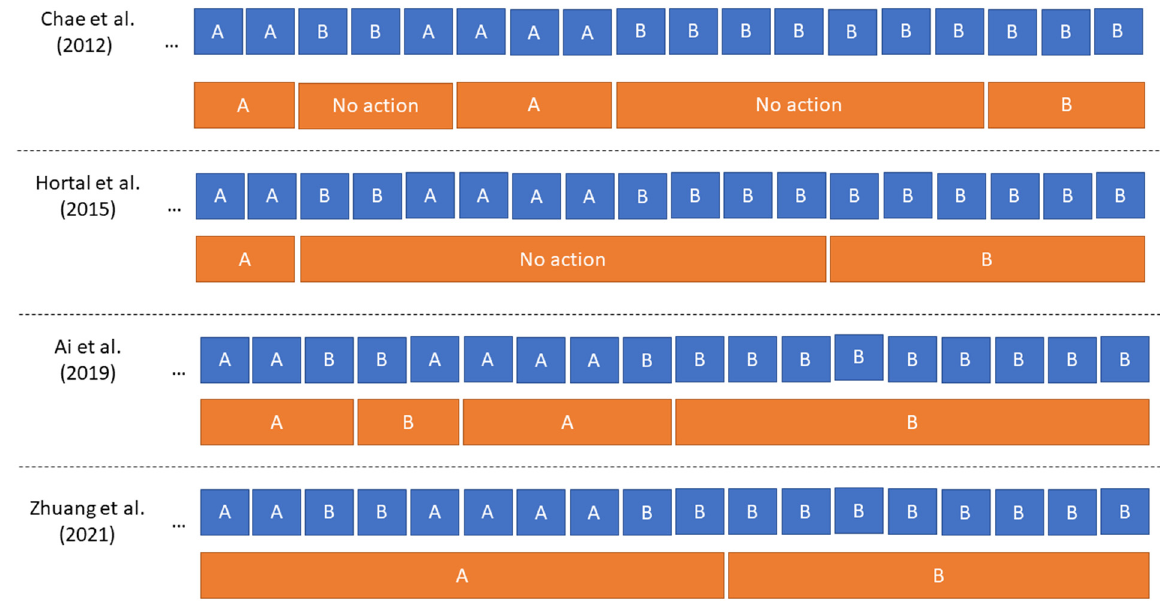
Figure 5. Comparing different false-alarm approaches. The blue bars show the BCI classifier output at the previous time step, and the orange bars show the decision made at the current time step. The example is for a two-class problem in which A denotes the classifier label for one mental state and B is the label for the other state. Each mental state was related to a different movement in the dynamic device. During “no action” phases, movement of the device was paused. In this example, it was assumed that at the start, the BCI classifier was outputting in class A for a long period (more than eight consecutive samples). Four different approaches are presented, namely those by Chae et al. [73], Hortal et al. [74], Ai et al. [54] and Zhuang et al. [52].